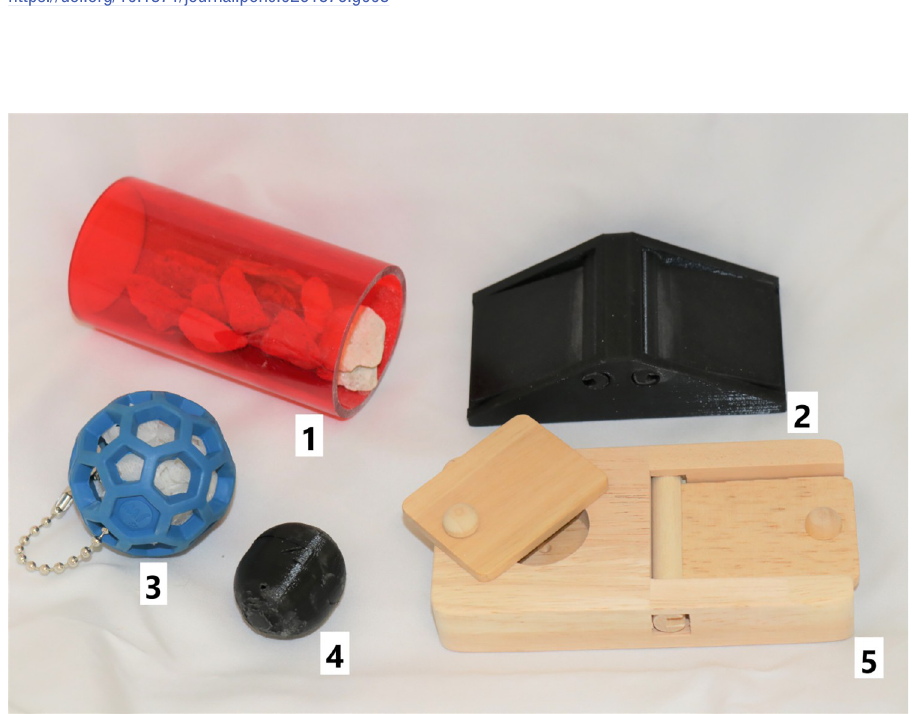
Fig 4. Enrichment items from the category foraging. 1 tube with stones, 2 flap puzzle, 3 lattice ball, 4 treat ball, 5 sliding puzzle.